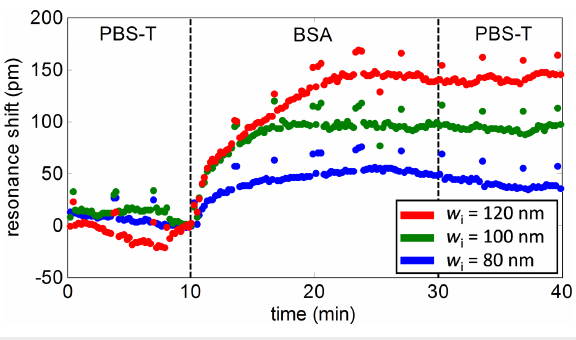
Figure 7: Time evolution of the PBG sensing response during the BSA detection experiment for one representative group of PBG sensing structures within the chip. Note that the PBG edge of the structures having w i = 140 nm fell out of our characterization range, so it was not possible to measure the corresponding sensing